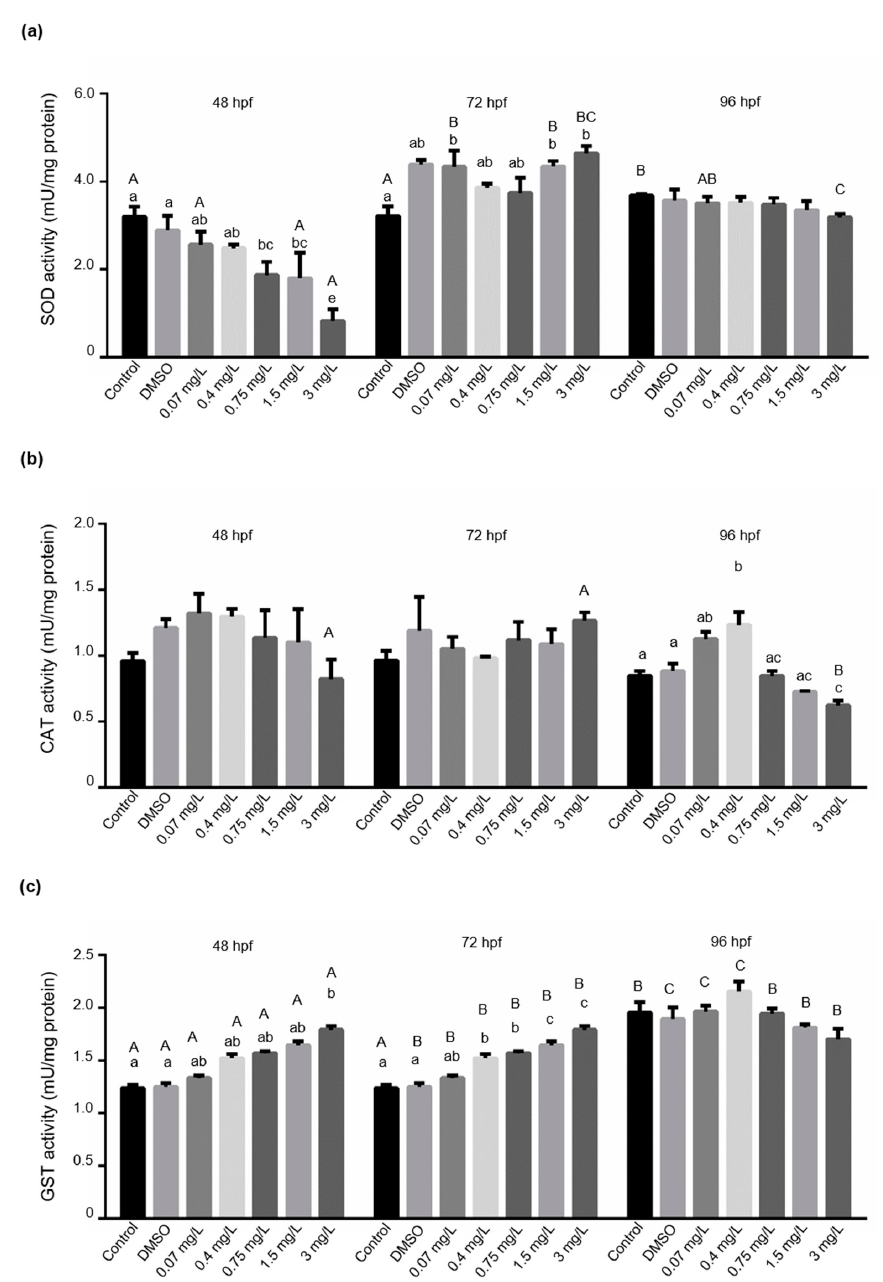
Figure 4. Effects of bendiocarb exposure on ( a ) superoxide dismutase (SOD) activity, ( b ) catalase (CAT) activity, and ( c ) Glutathione-S-transferase (GST) activity in a 48, 72 and 96-h test. Data represent the mean ± SD of two repeated experiments. Different lower-case letters indicate significant differences between concentrations within each time point (Tukey-test after one-way ANOVA; p < 0.05; N = 42). Different upper-case letters indicate significant differences between time points within each concentration (Tukey-test after one-way ANOVA; p < 0.05).